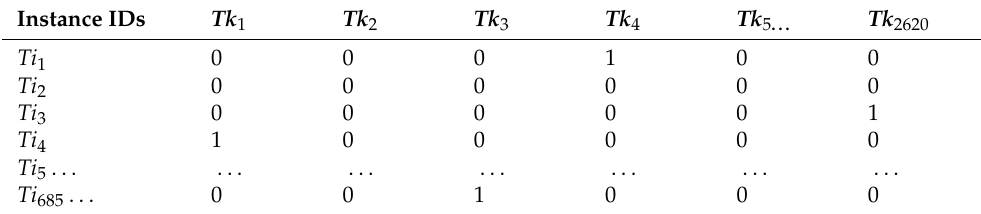
Table 3. Frequent itemset matrix.